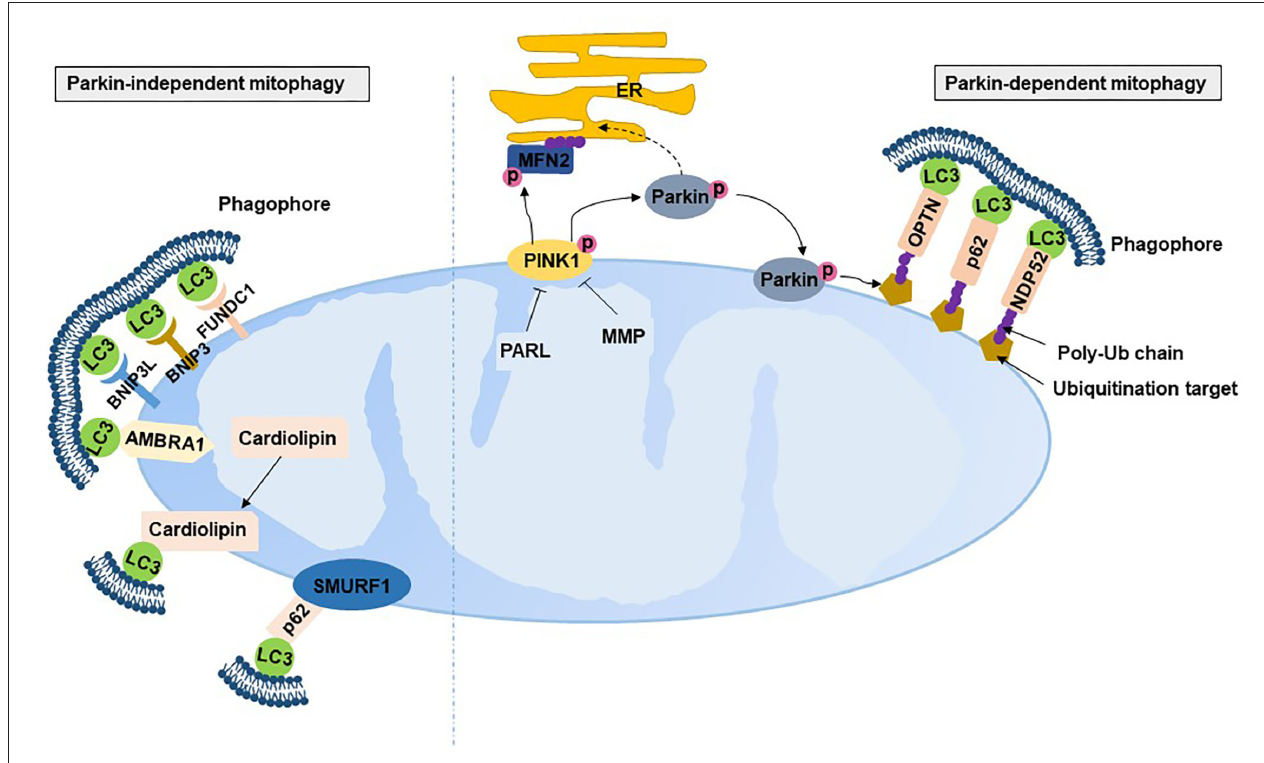
FIGURE 4 | Mitophagy. PARL, presenilin-associated rhomboid-like protease; MMP, mitochondrial-processing protease; PINK, PTEN-induced putative kinase 1; NDP52, nuclear dot protein 52; OPTN, optineurin; LC3, microtubule-associated protein 1 light chain 3; BNIP3, Bcl2/adenovirus E1B 19 kDa protein-interacting protein 3; BNIP3L, Bcl2/adenovirus E1B 19 kDa protein-interacting protein 3-like; FUNDC1, fun14 domain containing 1; AMBRA1, autophagy and beclin 1 regulator 1; SMURF1, SMAD specific E3 ubiquitin protein ligase